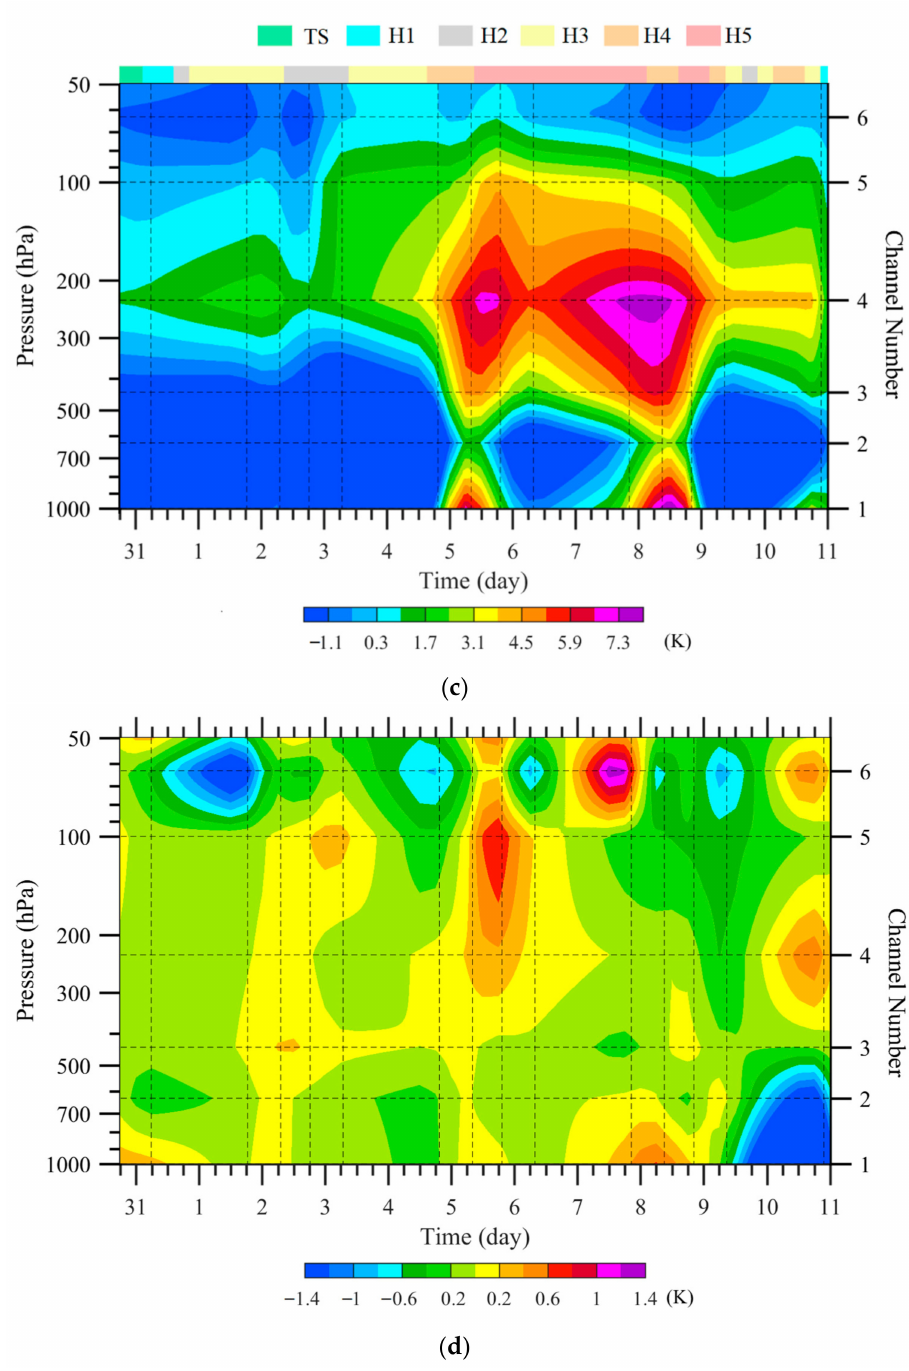
Figure 14. ( a ) The best track (black markers) of Hurricane Irma from 0000 UTC on 30 August to 0000 UTC on 12 September 2017. Different markers indicate intensity categories. The solid and hollow markers indicate different days. Red markers indicate the SSMIS observation time. ( b , c ) Temporal evolution of the vertical variations in SSMIS temperature anomalies at Irma’s center ( b ) before and ( c ) after noise reduction from 1800 UTC on 30 August to 0000 UTC on 11 September 2017. ( d ) The detected noise. The times when Hurricane Irma’s center was located within SSMIS swaths are indicated by short red lines in ( a ) and black dashed vertical lines in ( b – d